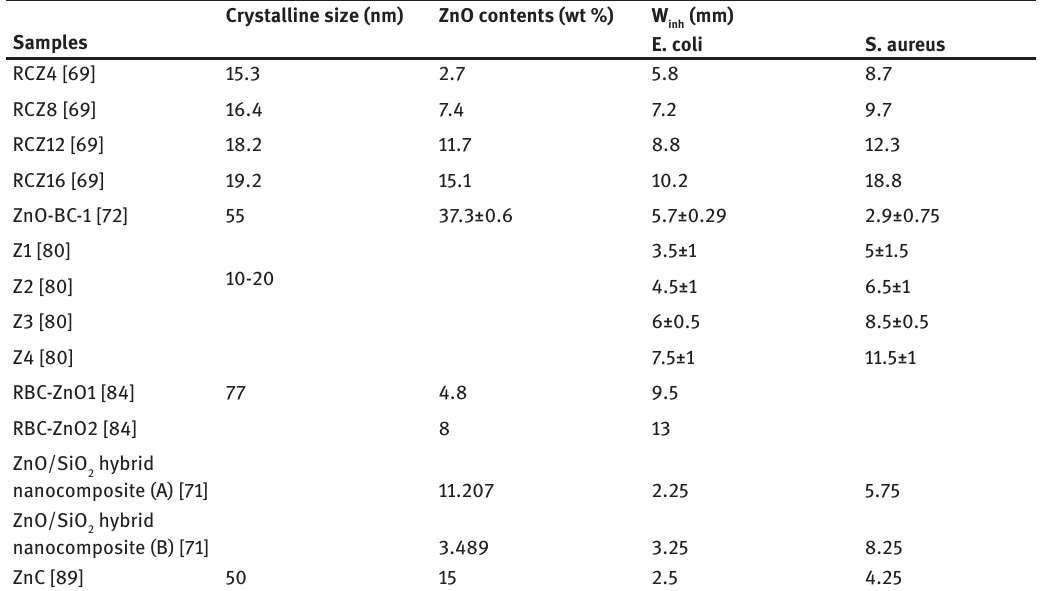
Table 5: The mean value of the inhibition zone width of composites.